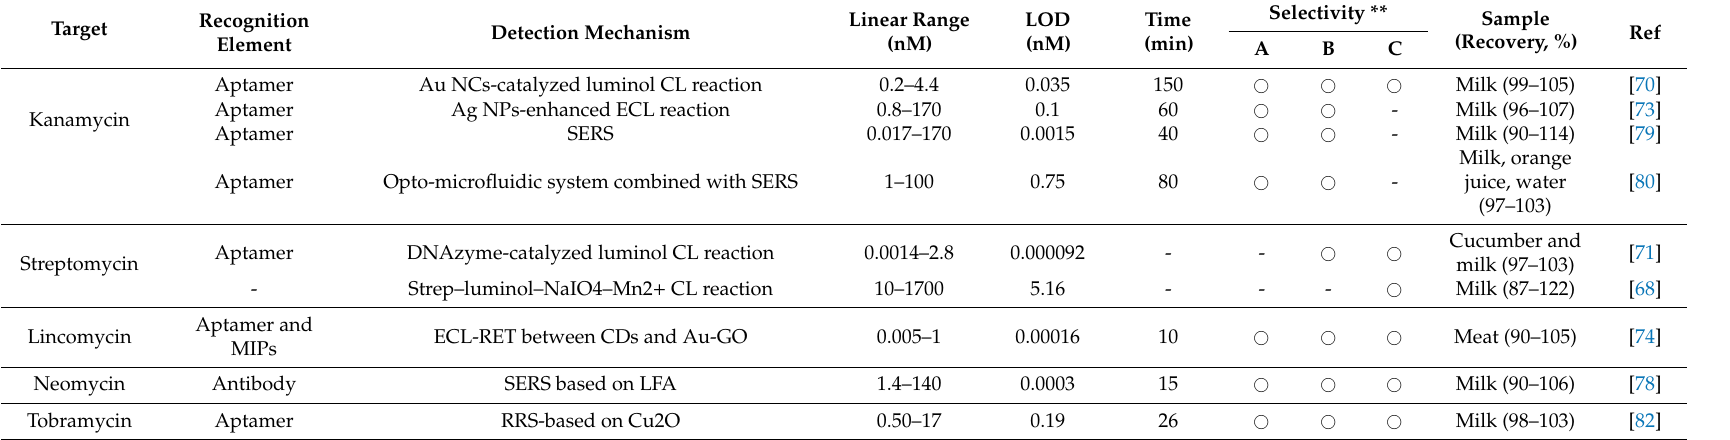
Table A3. Assay performance of other optical methods for the detection of AGs